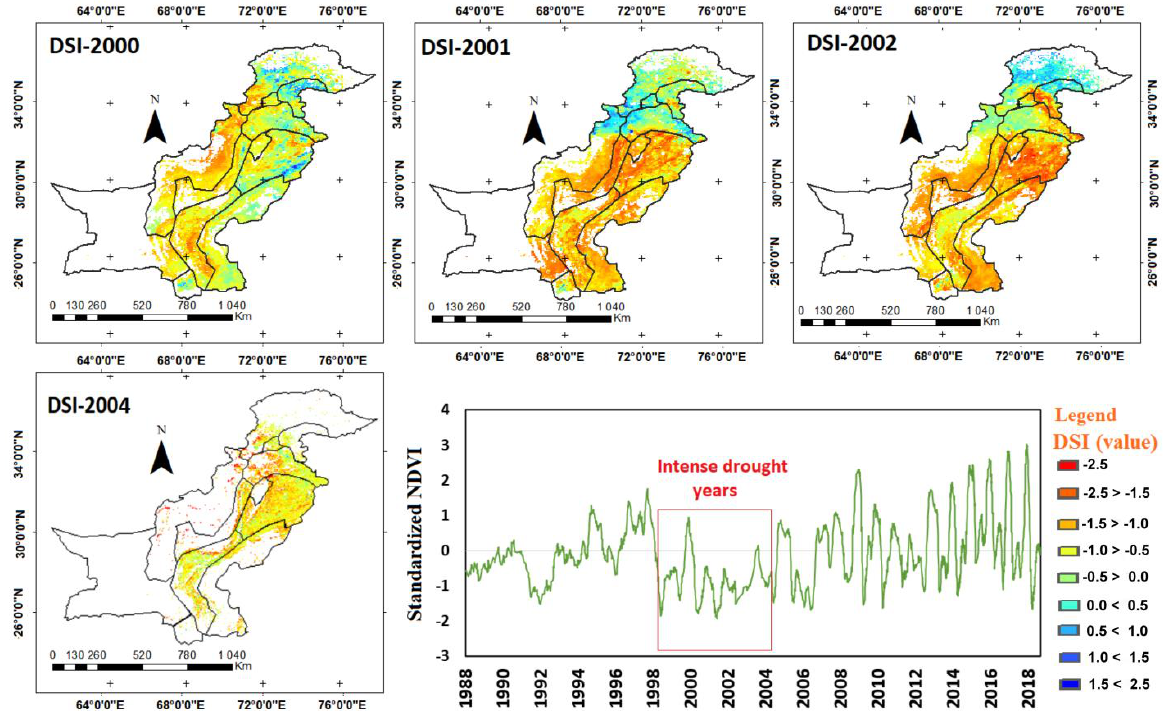
Figure 8. Spatial variations in Landsat drought severity index (DSI) in dry years (2000 – 2004) and average time series of NDVI from 1987 – 2018. Maps were prepared from Landsat images.